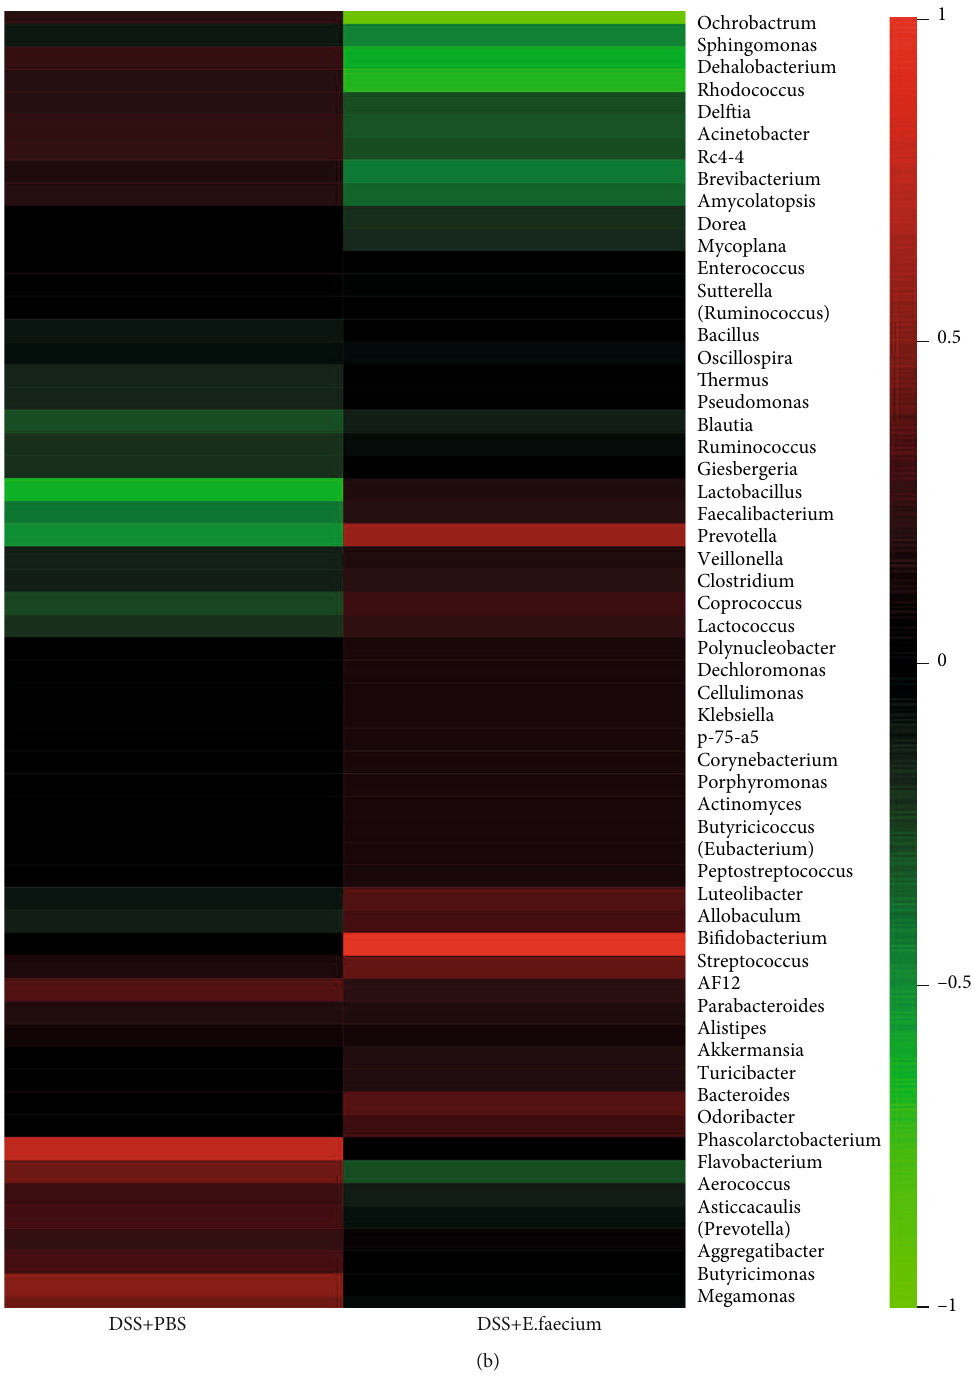
Figure 6: E. faecium treatment restores the imbalance of intestinal fl ora. (a) Microbiota composition in mice. (b) Heatmap of the abundance of bacterial genera in